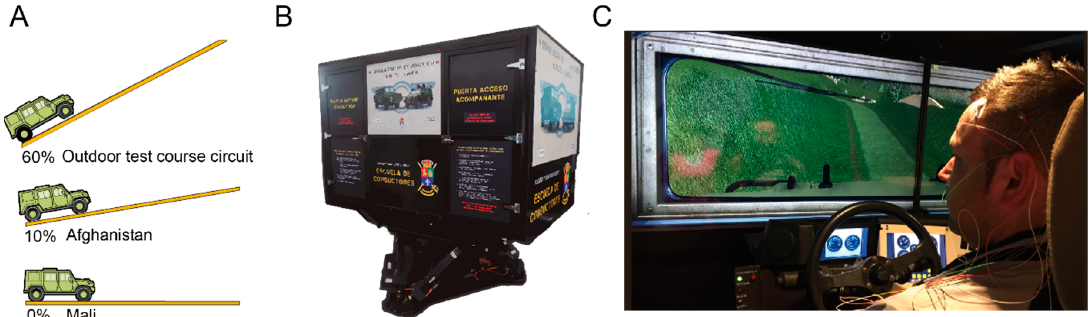
Figure 1. Experimental design and simulated mission scenarios. ( a ) Range of terrain complexity (maximum longitudinal slope gradient) across the three simulated scenarios: low (Mali), medium (Afghanistan), and high complexity (outdoor test course circuit) (partially adapted from www.ivecodefencevehicles.com). ( b ) The light tactical multirole vehicle (LMV) Lince simulator used in the study. An LMV Lince cabin is installed on a 6-degree motion feedback platform (partially adapted from www.simfor.es). ( c ) A participant sitting in the driver seat facing an image projection inside the LMV Lince cabin. Different electrodes are visible on his scalp.